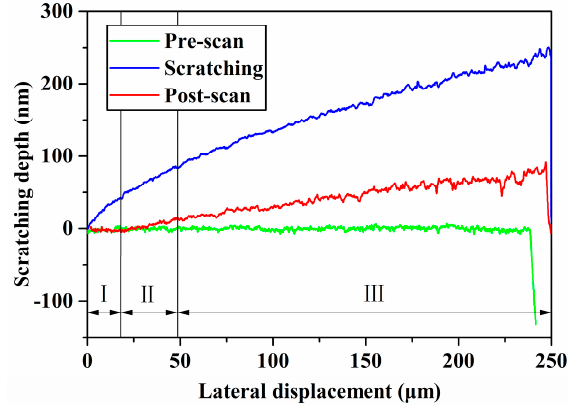
Figure 7. Scratching depth as a function of lateral displacement.